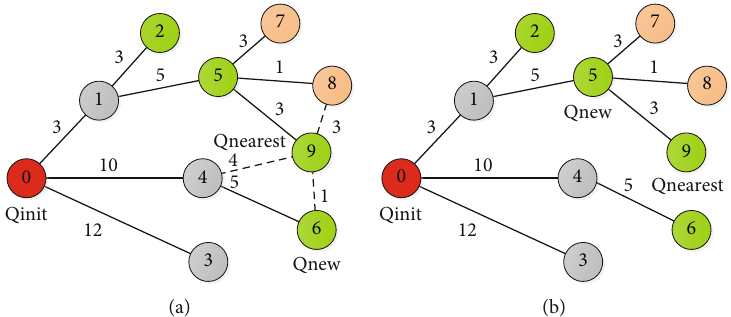
Figure 5: Process of reselecting the parent node.